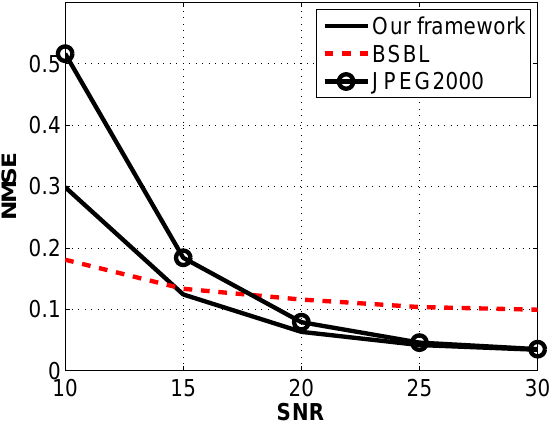
Figure 7. Reconstruction performance under Gaussian noise for a fixed CR (2:1), with varying signal-to-noise ratio (SNR).